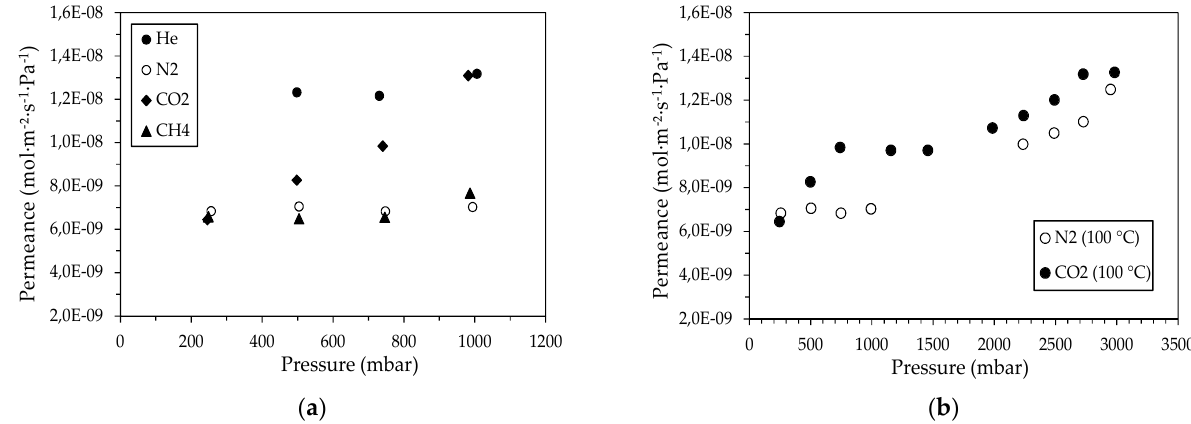
Figure 8. Permeance of ( a ) He, N 2 , CO 2 , and CH 4 gases at 100 ◦ C and ( b ) N 2 and CO 2 gases at 100 ◦ C, through the CM5 membrane, as a function of the pressure. Table 5. Mean ideal selectivity values for the pairs of single gases H 2 , N 2 , and CO 2 with helium, for the CM5 membrane, over the entire experimental pressure range at 100 °C, in comparison to the corresponding Knudsen ideal selectivities.